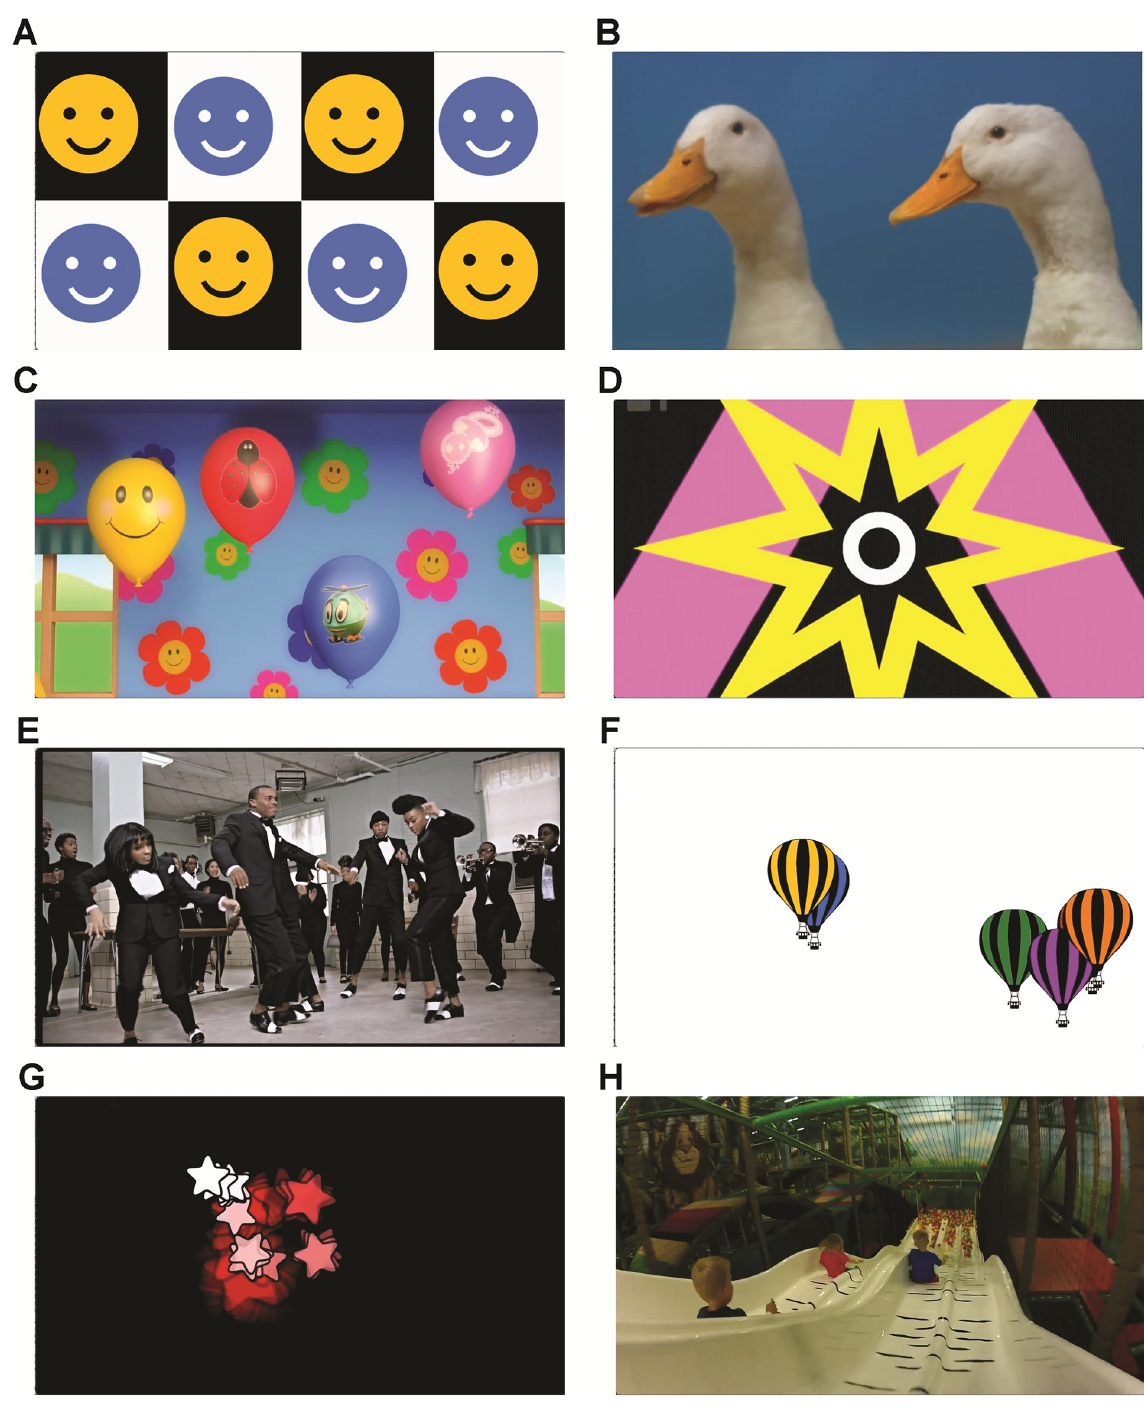
Fig 2. Static images of video stimuli.